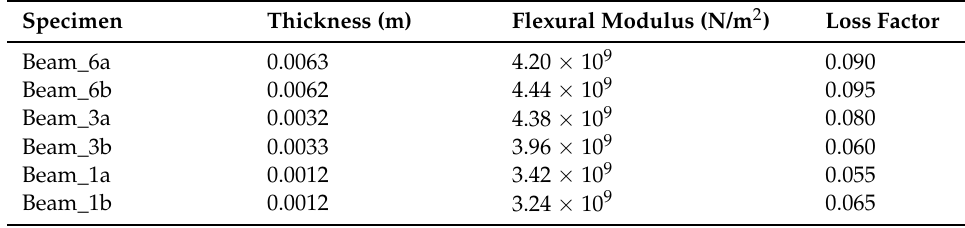
Table 7. Frequency-independent identified parameter combinations with minimum δ 1